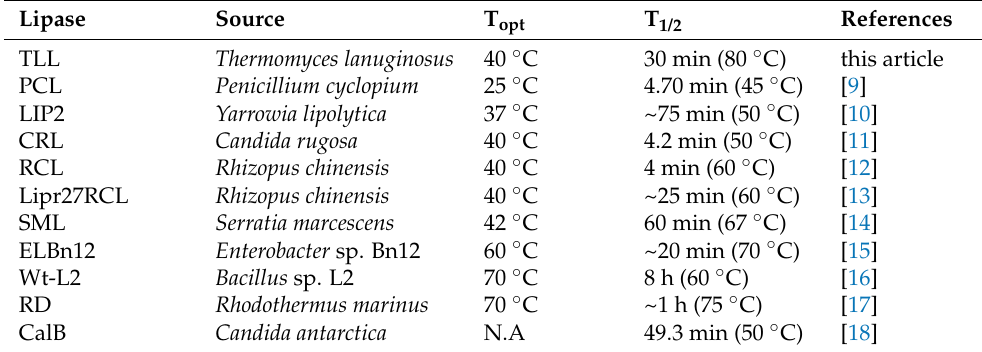
Table 1. Sources and thermal stability of microbial lipases. Lipase Source T opt T